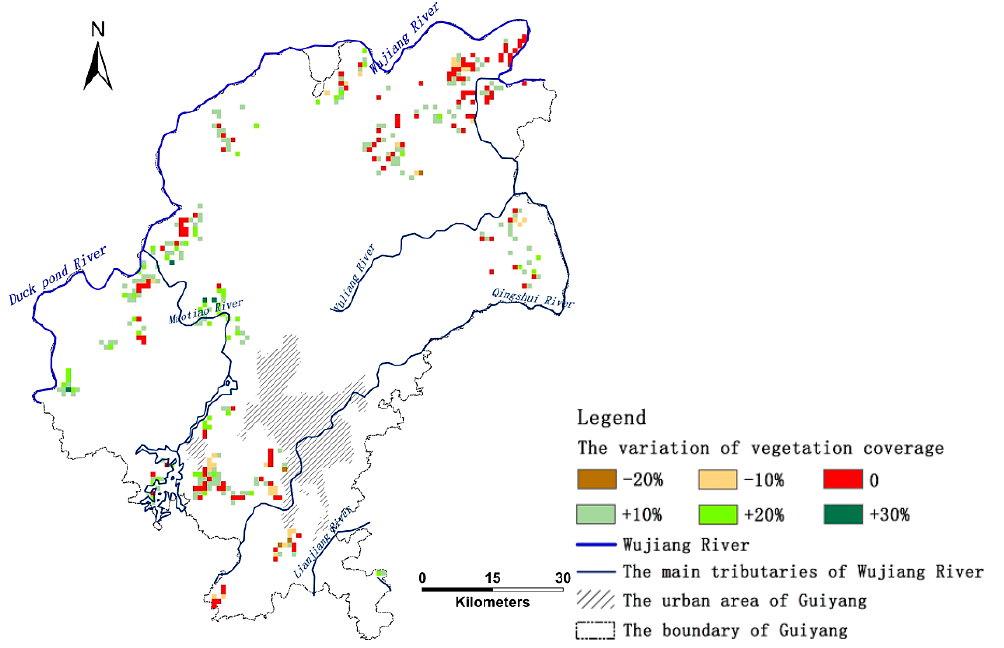
Figure 11. Variation of vegetation coverage from 2003 to 2013 in typical leaky area.